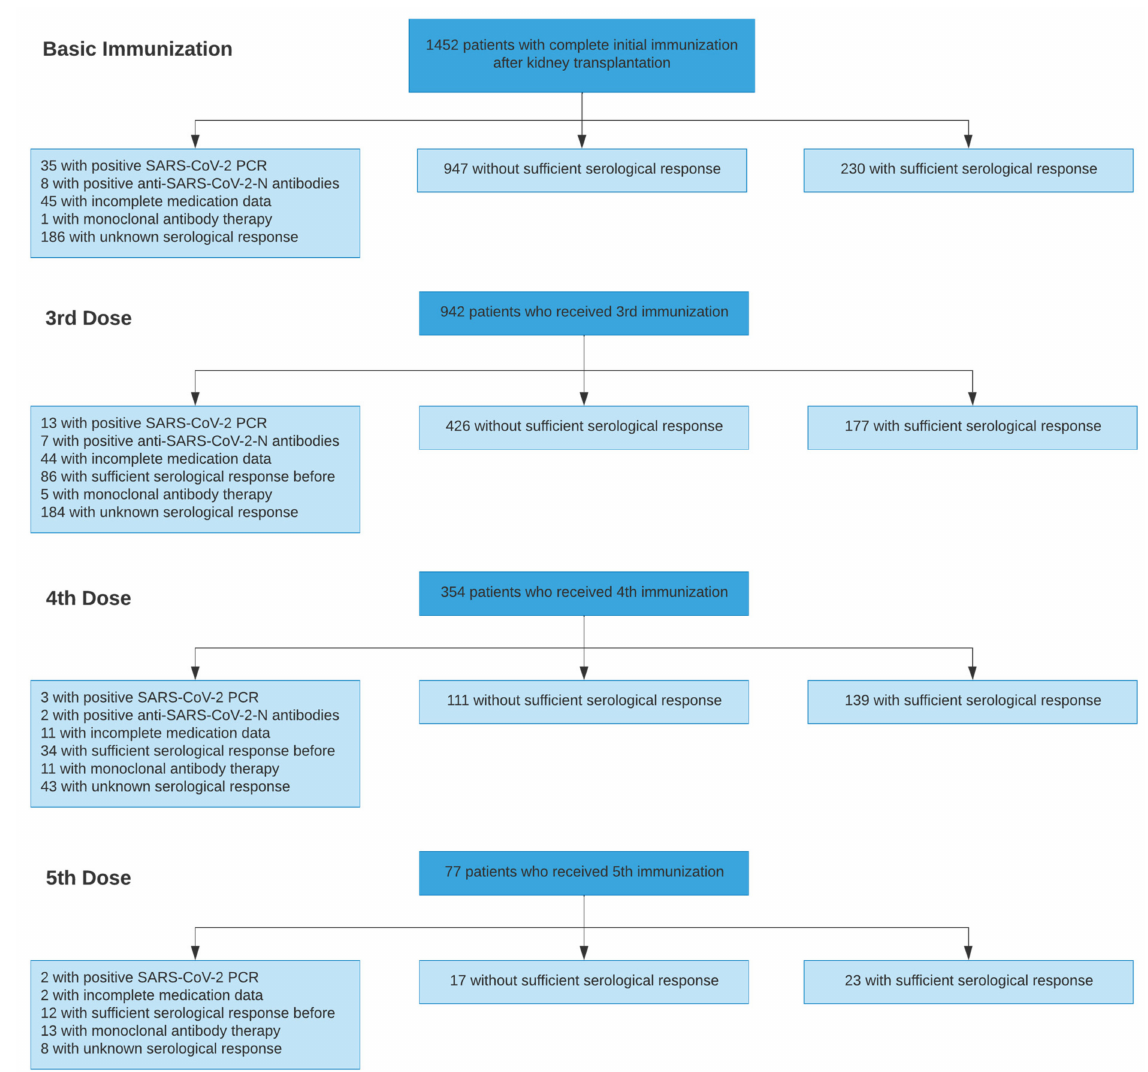
Figure 1. Patient flow diagram showing the number of patients included into each analysis and the number of excluded patients and the respective reasons for